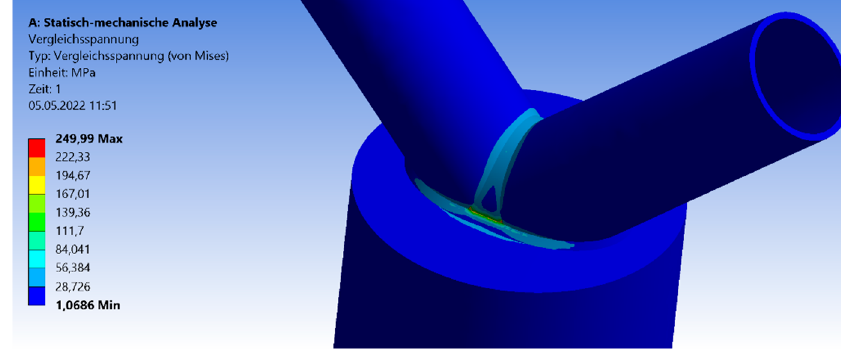
Figure 10. Stresses—symmetrical 45° model.